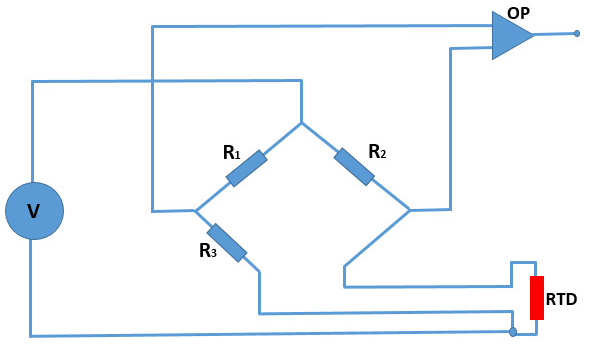
Figure 6. Wheatstone bridge circuit incorporating the fabricated RTD sensor. Table 5. Conditions for keeping the self-heating temperature change less than 1 °C in a Wheatstone bridge circuit.